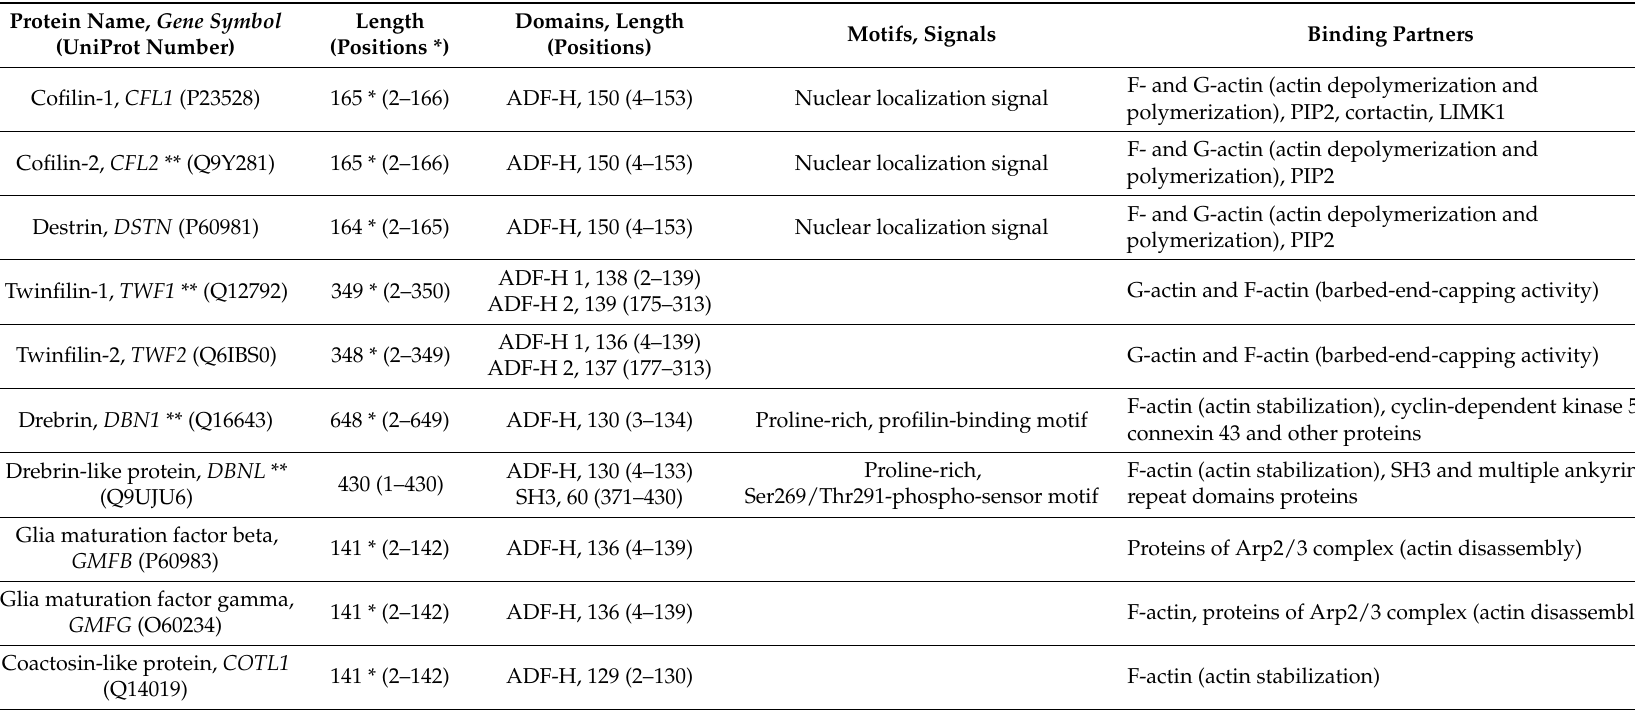
Table 1. Characteristics of the main human actin-depolymerizing factor (ADF)/cofilin superfamily members according to [56–63] and